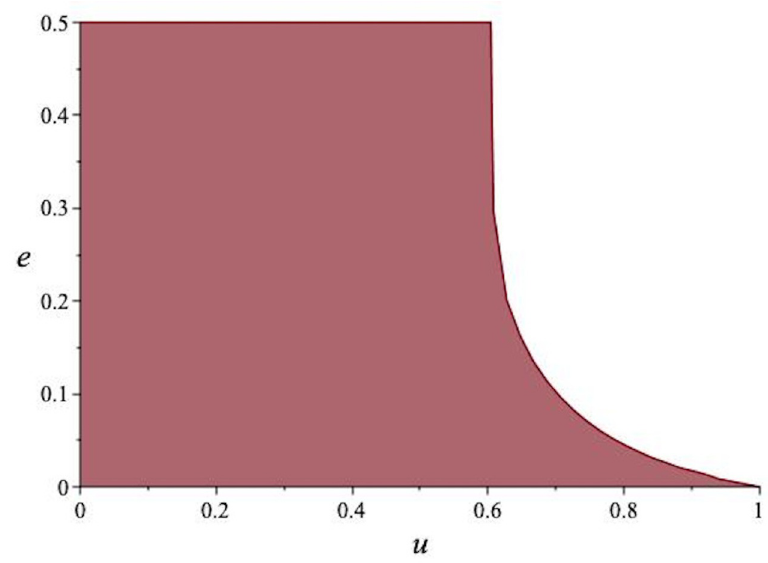
Figure 7 . Plot of “ruled out” region of the ( u, e ) -plane. Here, the region shaded in red is part of the parameter space where we do not expect solutions to occur, as conditions (C1) and (C2) cannot be simultaneously satisfied. The remaining unshaded region in the upper right corner may or may not have solutions (our procedure for ruling out regions of the parameter space was not